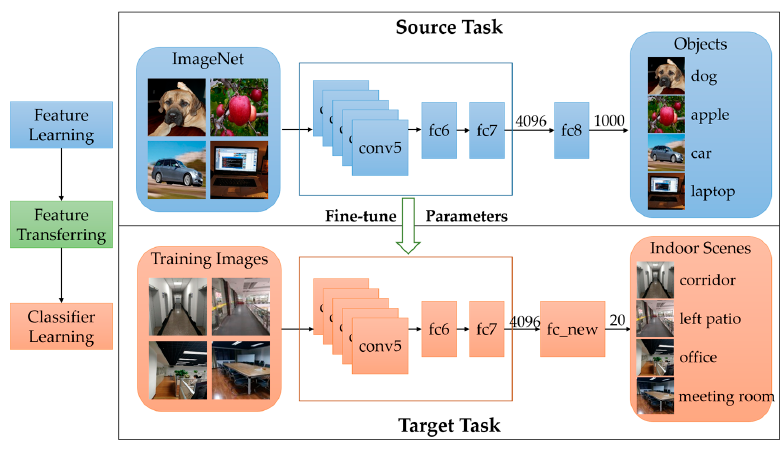
Figure 7. Fine-tuning a pre-trained network for indoor scene recognition. The outputs of final fully-connected layer for indoor scene task are 20 instead of 1000 in CaffeNet.